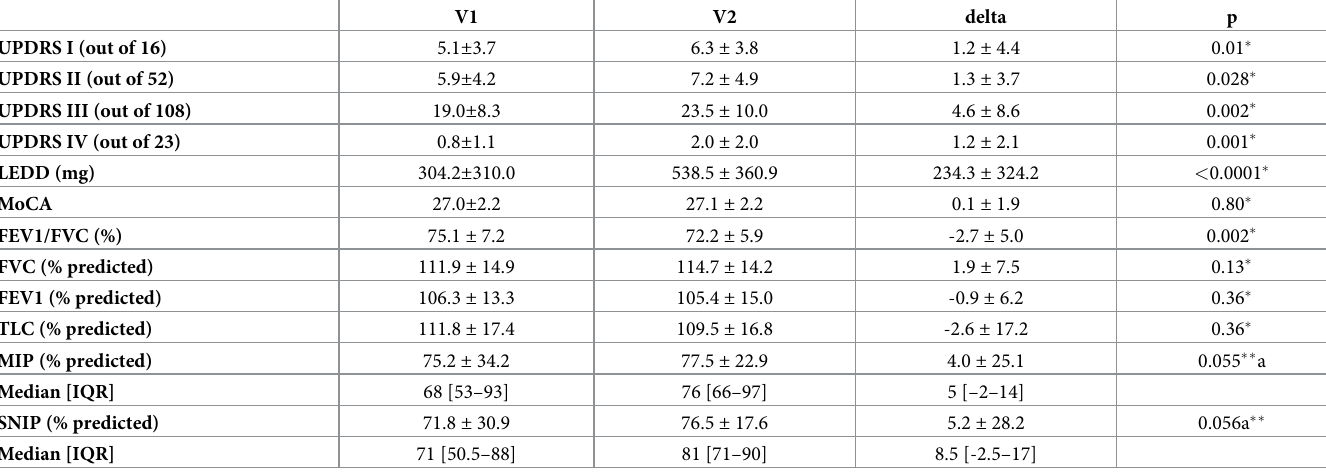
Table 4. Changes over time in clinical and PFT parameters between V1 and V2.